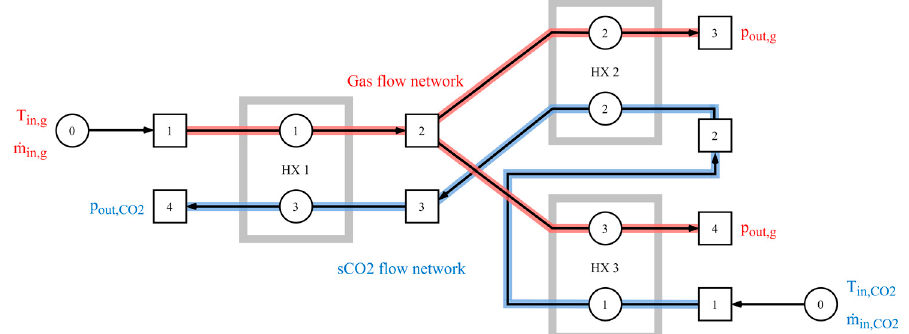
Figure 4. Thermofluid network model superimposed onto the physical layout of the heat exchanger system. Heat exchanger—HX.